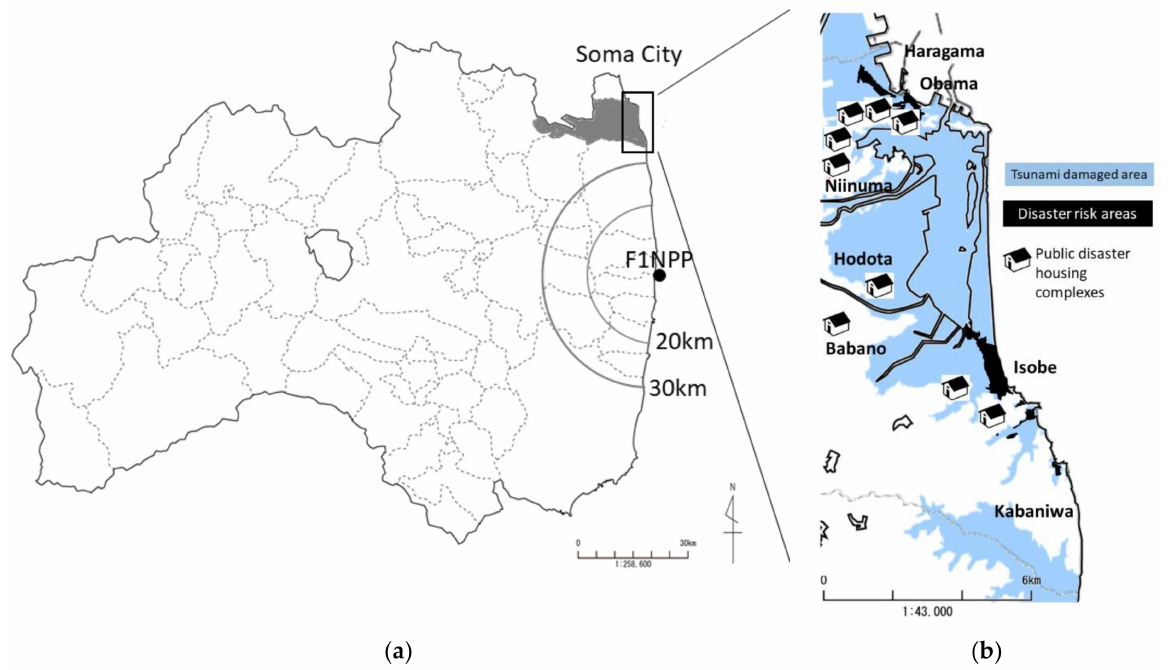
Figure 1. ( a )The geographical location of Soma City in Fukushima Prefecture, ( b ) illustration of its coastal area (areas that suffered tsunami damage, disaster risk areas, and public housing